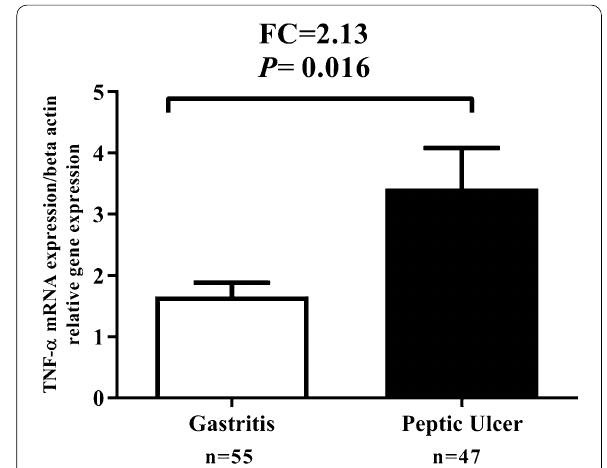
Fig. 4 Comparison of TNF‑α mRNA expression in PUD and gastritis H. pylori- infected individuals. TNF‑α mRNA expression was significantly increased in PUD H. pylori- infected individuals than gastritis H. pylori- infected individuals. P < 0 .05 was considered statistically significant by independent‑samples t‑test (N